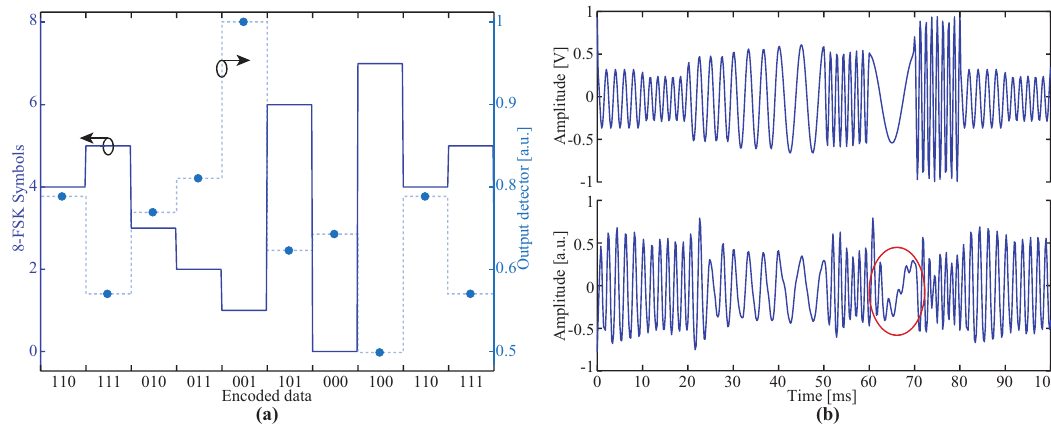
Figure 8. ( a ) 8-FSK encoded data symbols, ( b ) modulation and received signal for 8-FSK in back to back